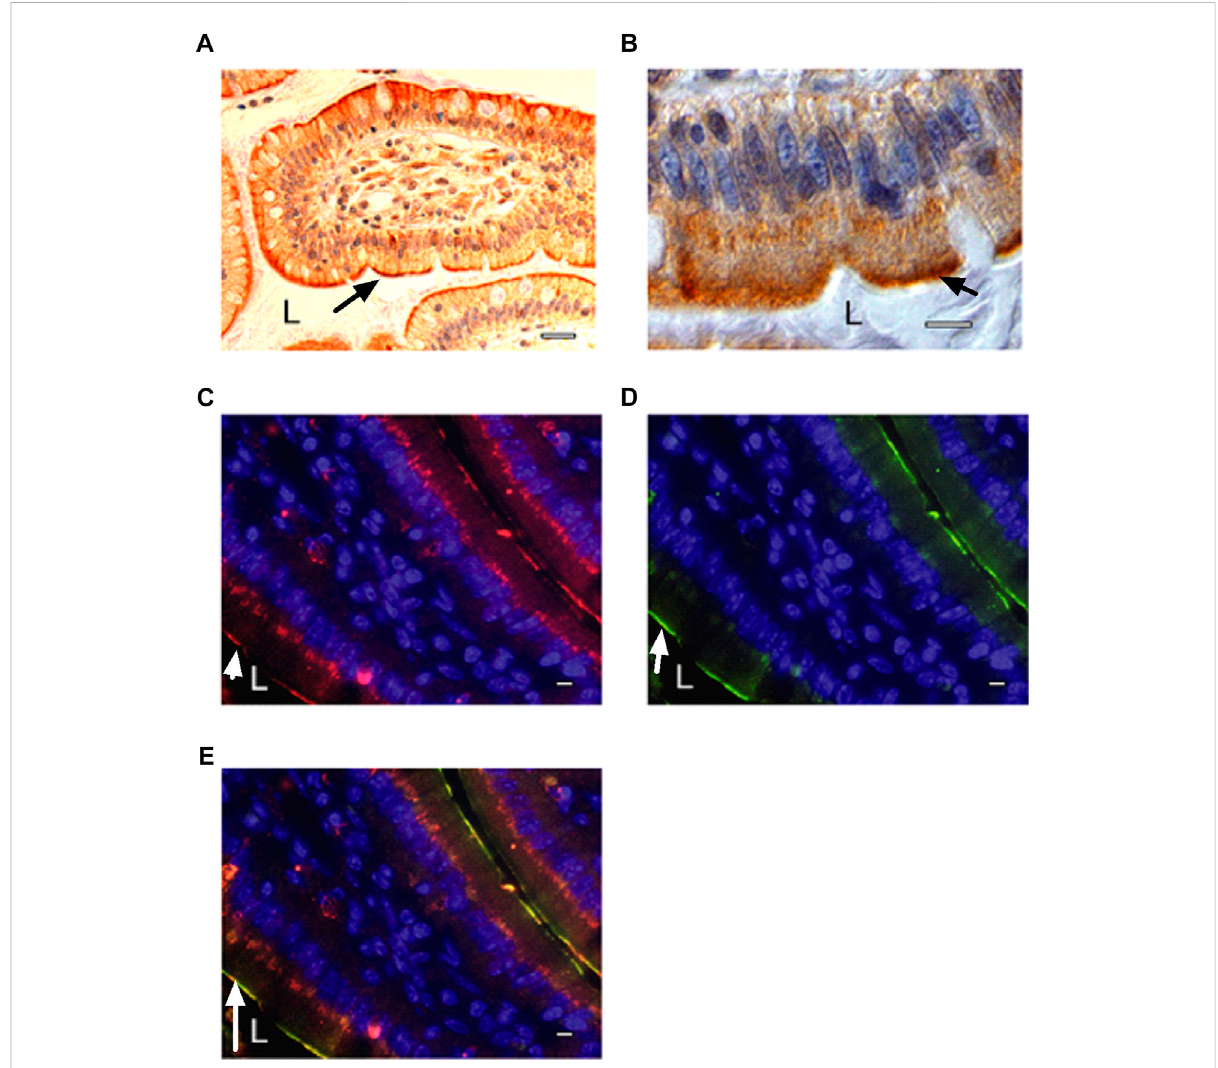
FIGURE 1 Localization of β 2 -ARs at the apical side of intestinal epithelial cells. (A) β 2 -AR immunostaining using Abcam antibodies in human duodenal biopsy sample as revealed by peroxidase staining (L: lumen of intestine). Secondary antibodies were peroxidase-labeled goat anti-rabbit antibodies (Abcam). The terminal part of a villus is shown with some surface sections of adjacent villi. (B) magni fi cation of β 2 -AR immunostaining in individual epithelial cells (L: lumen of intestine). The strong staining on the apical plasma membrane is clearly visible as well as the more diffuse staining inside the enterocytes, possibly in ER/Golgi. The nucleus is colored blue with DAPI. (C – E) immunostaining in mouse intestinal tissue sections of (C) β 2 -ARwithrabbitantibodies(AssayDesign)andCY3-conjugatedsecondaryanti-rabbitantibodies(Jackson)(red)and (D) SGLT1withgoatantibodies (M19, Santa Cruz) and FITC-conjugated secondary anti-goat antibodies (Jackson) (green), (E) overlay showing co-localization of β 2 -AR and SGLT1. The nucleus is colored blue with DAPI. A single villus is seen in the middle of the panels, with one side adjacent to lumen at the bottom left and showingasinglelineof β 2 -ARorSGLT1apicalstainingontheenterocytesofthatside.Ontheothersideofthevillus,attheupperrightcorner,itisjust adjacent ofa nextvillus with very little lumen inbetweenthetwo villi, so that a double line oftwo apical plasmamembranes with staining of β 2 -ARor SGLT1 is visible. SGLT1 staining is largely con fi ned to the apical plasma membrane while β 2 -AR staining is also present in more diffuse form at the bottom of the epithelial cells, possibly in the ER/Golgi. The arrow indicates either β 2 -AR (A – C) , SGLT1 (D) or co-localization of the two (E) . The scale bar is 100 μ m (A) or 10 μ m (B – E) . All fl uorescent images were taken under similar electronic ampli fi cation conditions. Representative results are shown from several samples investigated in all